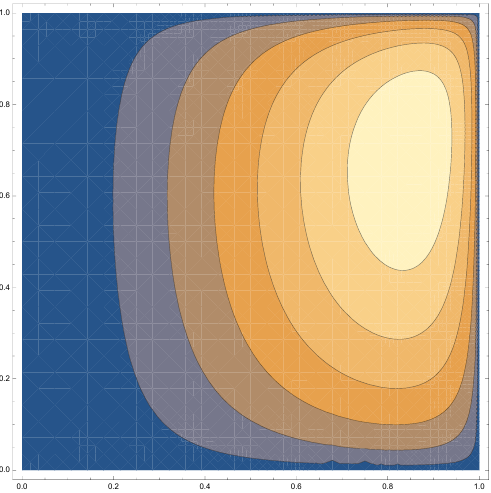
Figure A13. The bivariate Kumaraswamy density (Equation (1)) plot, where α = 2.5, β = 1.5, θ = 0.5 and δ = 0.9.